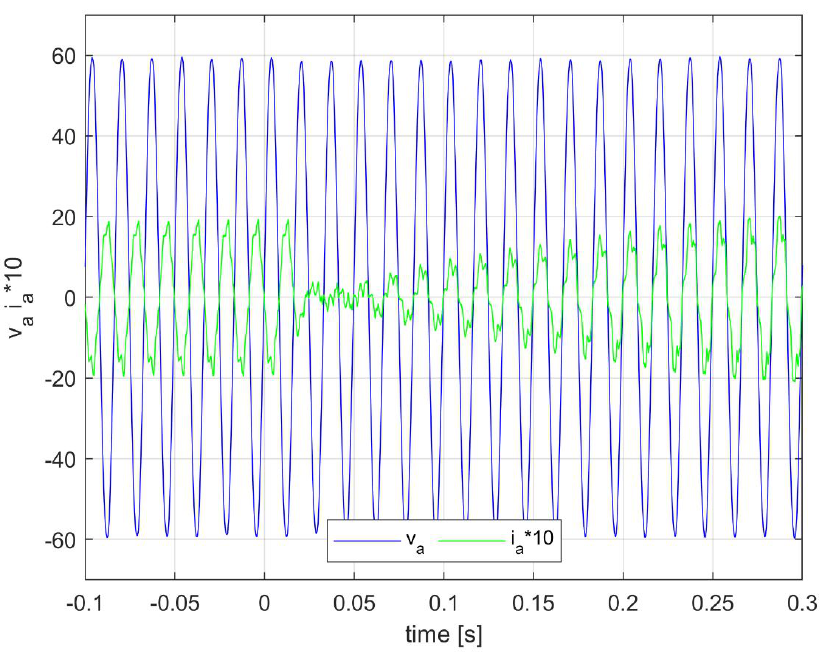
Figure 15. Inverter current ( i a ) and grid voltage ( v a ) when the additional load is